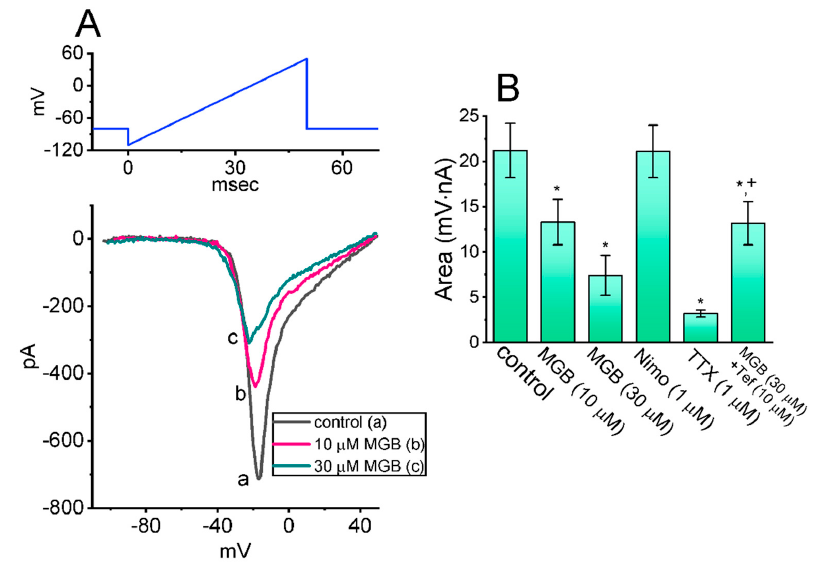
Figure 5. Effect of MGB on window I Na ( I Na(W) ) elicited by short ascending ramp voltage (V ramp ). The experiments were conducted with the tested cell voltage-clamped at − 80 mV, and the V ramp with a range from − 110 to +50 mV was applied for a duration of 50 ms. ( A ) Representative current traces were acquired in the control period (a, black) and during cell exposure to 10 μ M MGB (b, pink) or 30 μ M MGB (c, green). The voltage protocol used is illustrated in the upper part, and the downward deflection indicates the occurrence of inward current. ( B ) Summary bar graph showing the effect of MGB, nimodipine (Nimo), tetrodotoxin (TTX), and MGB plus tefluthrin (Tef) on the area of I Na(W) (mean ± SEM; n = 8). Each area was measured at the voltages ranging between − 40 and +40 mV during the upsloping V ramp . * This result is significantly different from control ( p < 0.05) and + significantly different from MGB (30 μ M) alone group ( p < 0.05).